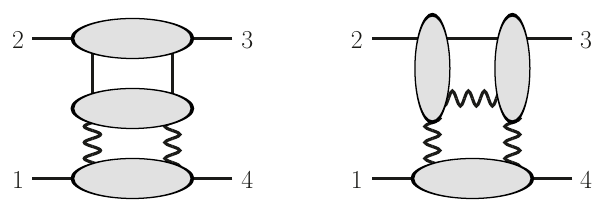
Figure 13 . Examples of cuts that are discarded because they have no further classical or iteration contributions to the potential that are not already found in the cuts of (cid:12)gure